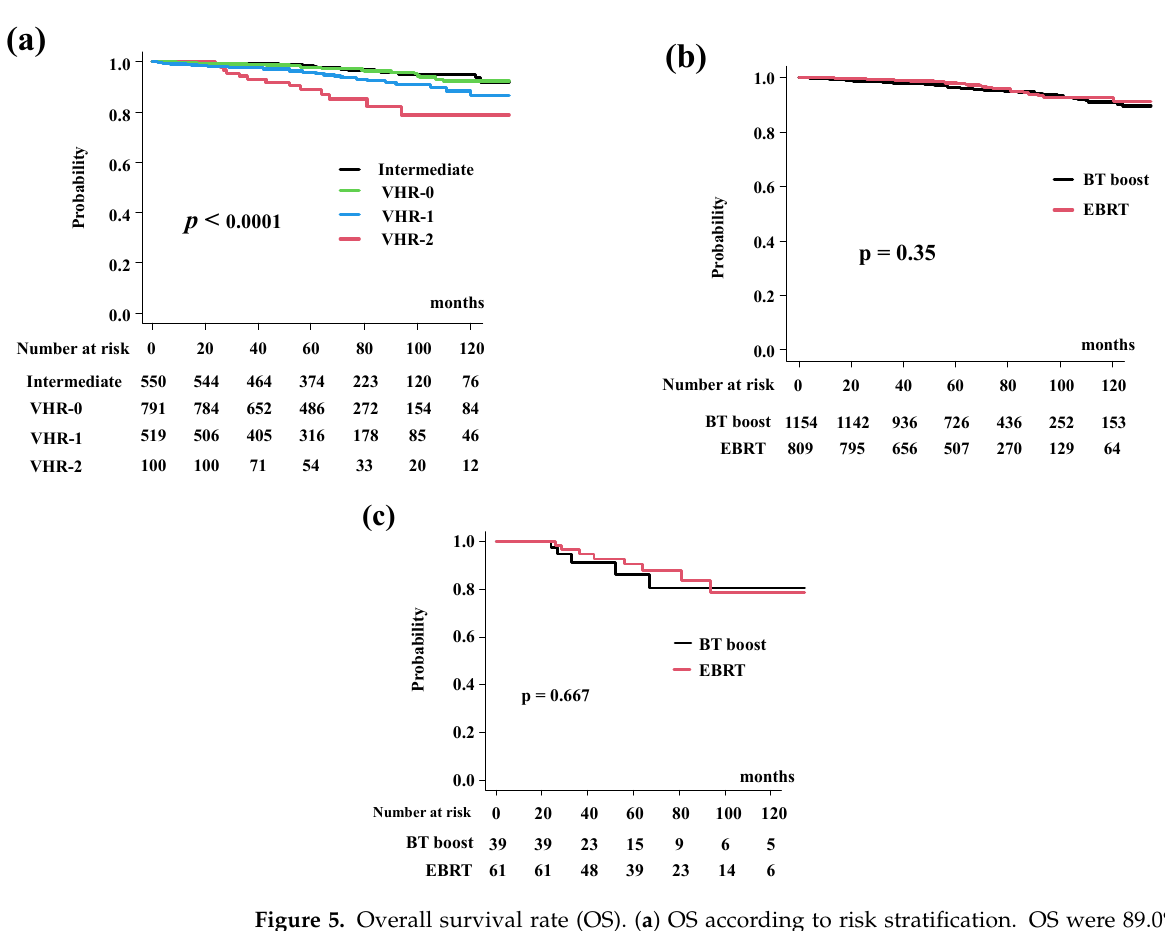
Figure 5. Overall survival rate (OS). ( a ) OS according to risk stratification. OS were 89.0% (95% CI: 99.3%) at 5 years in the VHR-2, VHR-1, VHR-0, and intermediate groups, respectively ( p < 0.0001). ( b ) Comparison of bDFS between EBRT and BT-boost. ( c ) Comparison of bDFS between EBRT and BT-boost in VHR-2 group. The BT-boost group showed an equivalent OS to those for EBRT in all